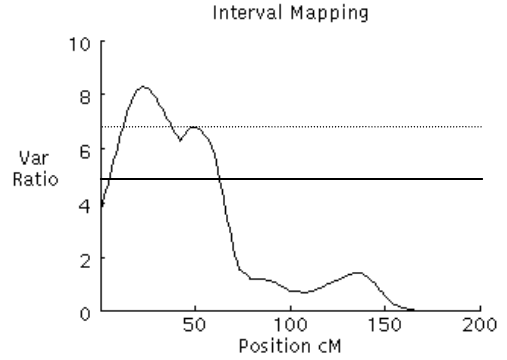
Figure 3. F-ratio curves for body fat on chromosome 7. The x-axis indicates the relative position on the linkage map. The y-axis represents the F-ratio. The two lines indicate the 5% chromosome- wide (  ) and 1% chromosome-wide (  ) significance level from the permutation test.